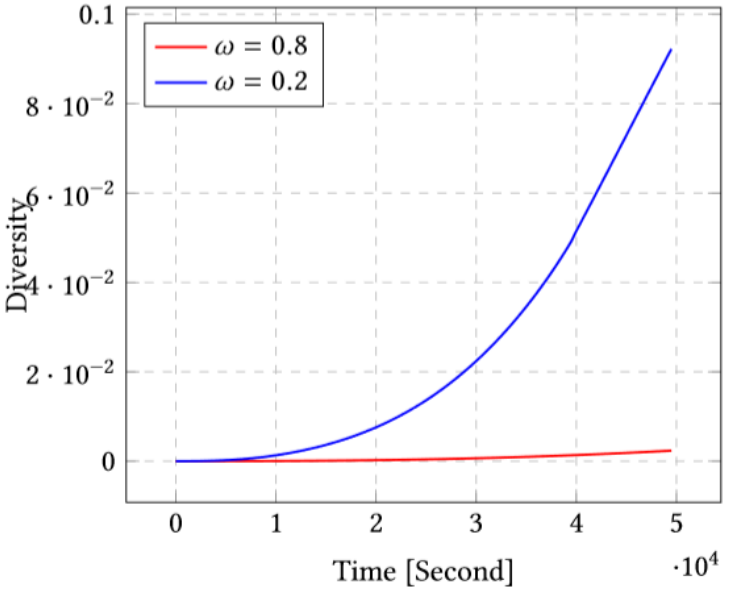
Figure 4. Diversity for ω = 0.8 and ω = 0.2 for the case of 10